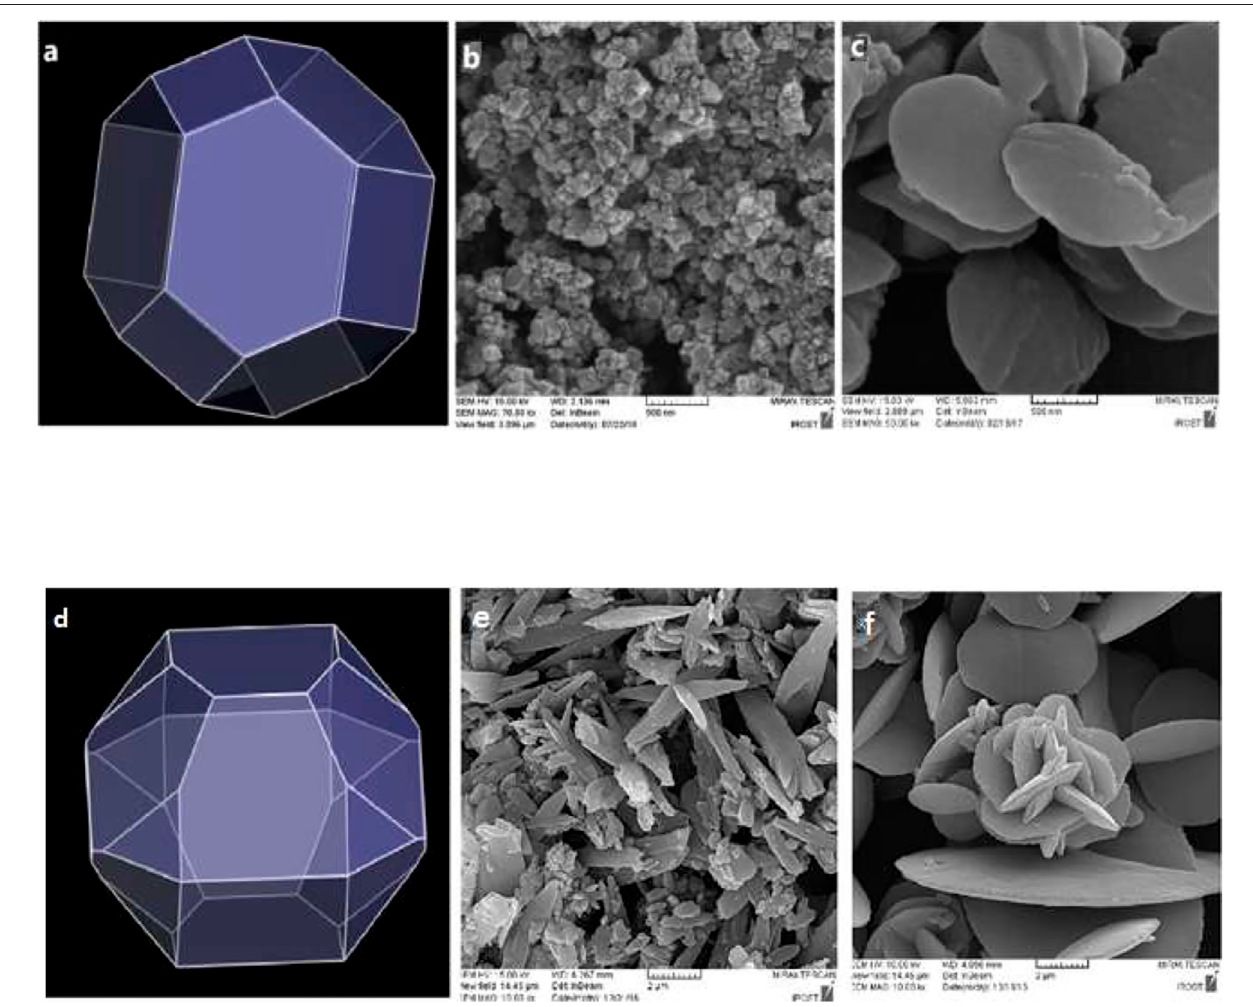
FIGURE 7 | Predicted morphology of (A) TMU-50 and (D) TMU-51 in DMF by BFDH method. FE-SEM images of TMU-50 (B) : 0.01 M (C) : 0.05 M (particle size 10 – 50 nm),andTMU-51 (E) :0.01 M (F) :0.05 Mandbyusing1 hsonicationtime(particlesize100 – 500 nm).LuminescencepropertiesandSensingofTMU-50and51.